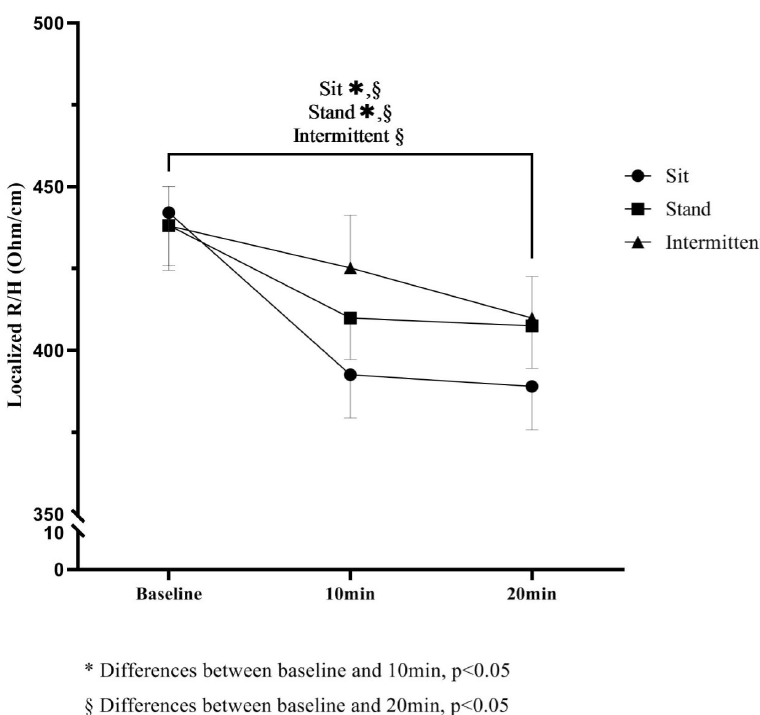
Figure 2. Localized R values standardized for height throughout